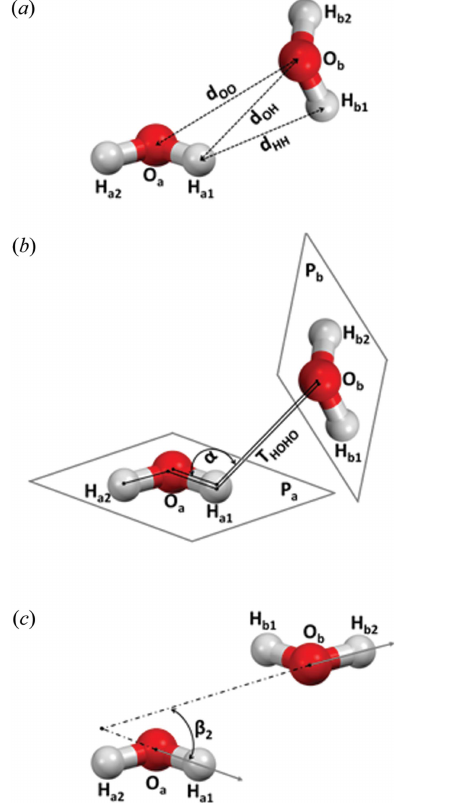
Figure 2 Geometric parameters and atom labelling used for the description of intermolecular interactions between two water molecules, a and b. ( a ) The distance between two oxygen atoms is d OO . H a1 represents the hydrogen atom that has the shortest non-bonded O (cid:6)(cid:6)(cid:6) H distance (O b (cid:6)(cid:6)(cid:6) H a1 ), which is d OH . H b1 represents the hydrogen atom that has a shorter H a1 (cid:6)(cid:6)(cid:6) H b distance, which is d HH . ( b ) The angle Oa—H a1 (cid:6)(cid:6)(cid:6) O b is (cid:2) . P a / P b is the dihedral angle between two water molecule planes. The torsion angle H a2 —O a —H a1 —O b is T HOHO . ( c ) Angles between vectors containing O— H bonds are denoted (cid:3) n . (cid:3) 1 represents the angle O a —H a1 (cid:6)(cid:6)(cid:6) O b —H b1 , (cid:3) 2 represents the angle O a —H a1 (cid:6)(cid:6)(cid:6) O b —H b2 . Only (cid:3) 2 is shown, the others have been omitted for